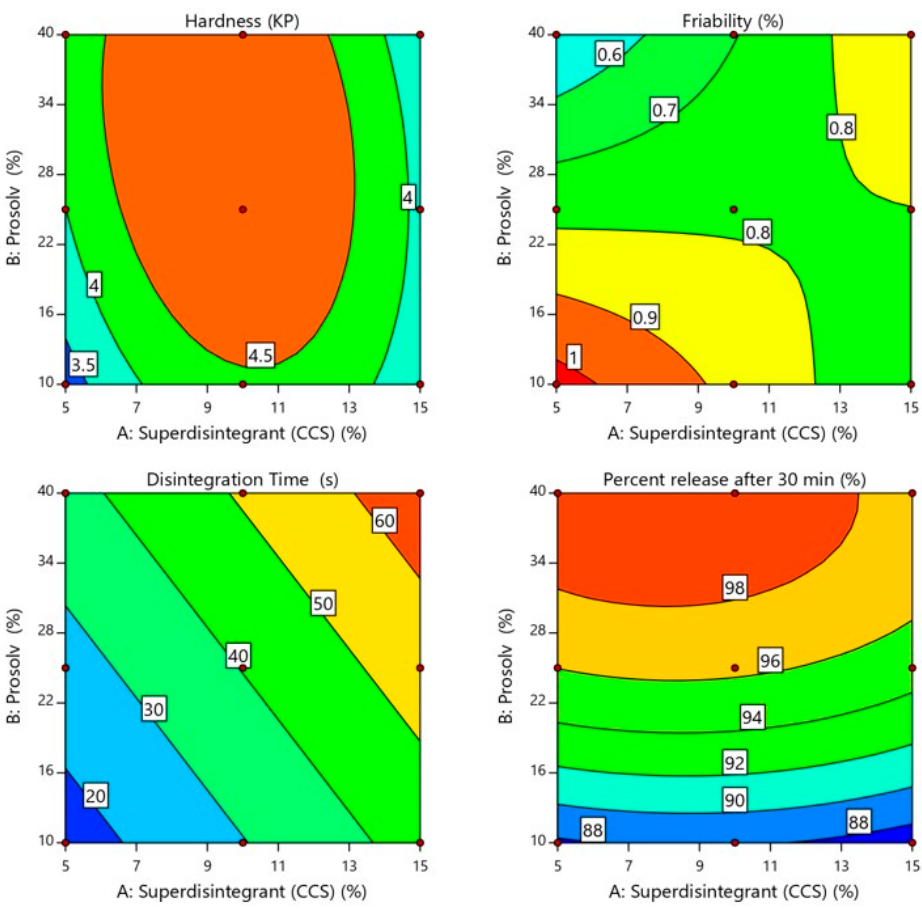
Figure 2. Influence of independent variables on hardness, friability, in vitro disintegration time and percent drug release after 30 min. of SUL-FDTs.